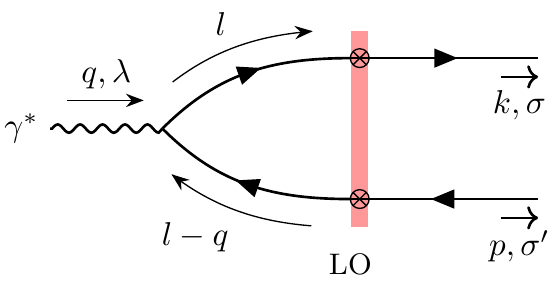
Figure 2 . Leading order contribution to the amplitude for dijet production. The cross symbol on the quark and antiquark legs refers to the CGC quark effective vertex, as represented in figure 1 and defined in eq.